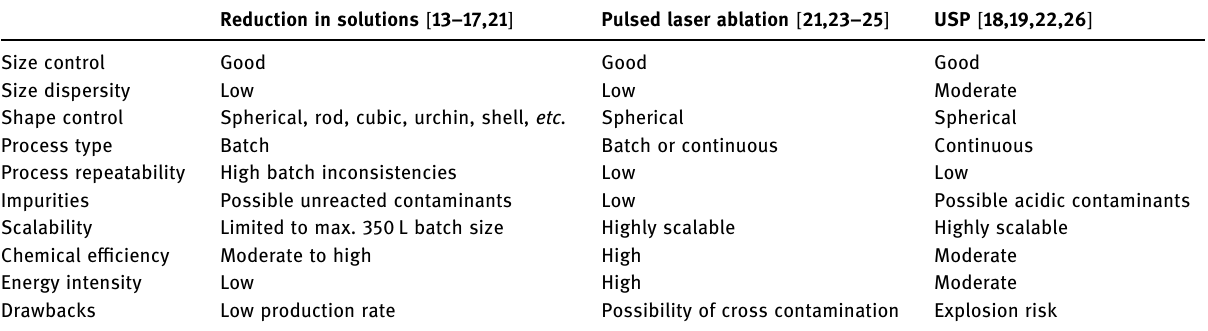
Table 1: Key technological parameters for AuNPs ’